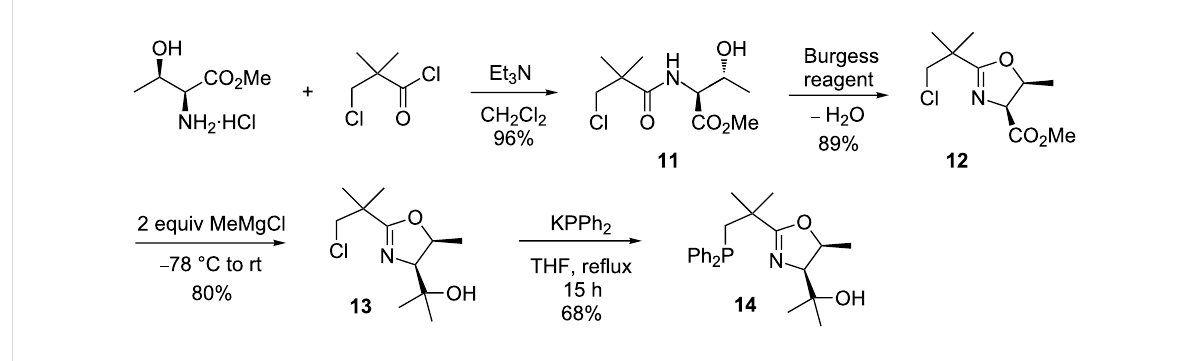
Scheme 4: Revisited synthetic strategy for the preparation of a threonine-based NeoPHOX ligand.